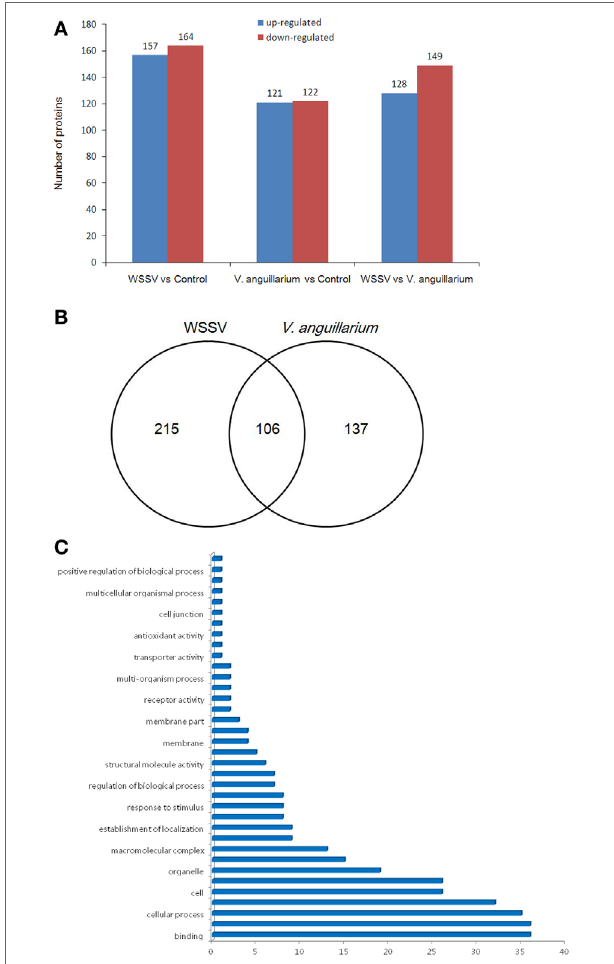
FigUre 3 | The differentially expressed proteins were evaluated by isobaric tags for relative and absolute quantitation analysis . The numbers represent the proteins that were upregulated or downregulated (more than 1.2-fold) compared with the control or Vibrio alginolyticus group (a) . Venn diagram of differentially expressed genes (B) . The numbers represented the proteins upregulated or downregulated (more than 1.2-fold) compared with the control. The statistics of gene ontology enrichment of the 106 proteins up- or downregulated significantly in white spot syndrome virus (WSSV) and V. alginolyticus infection (c)